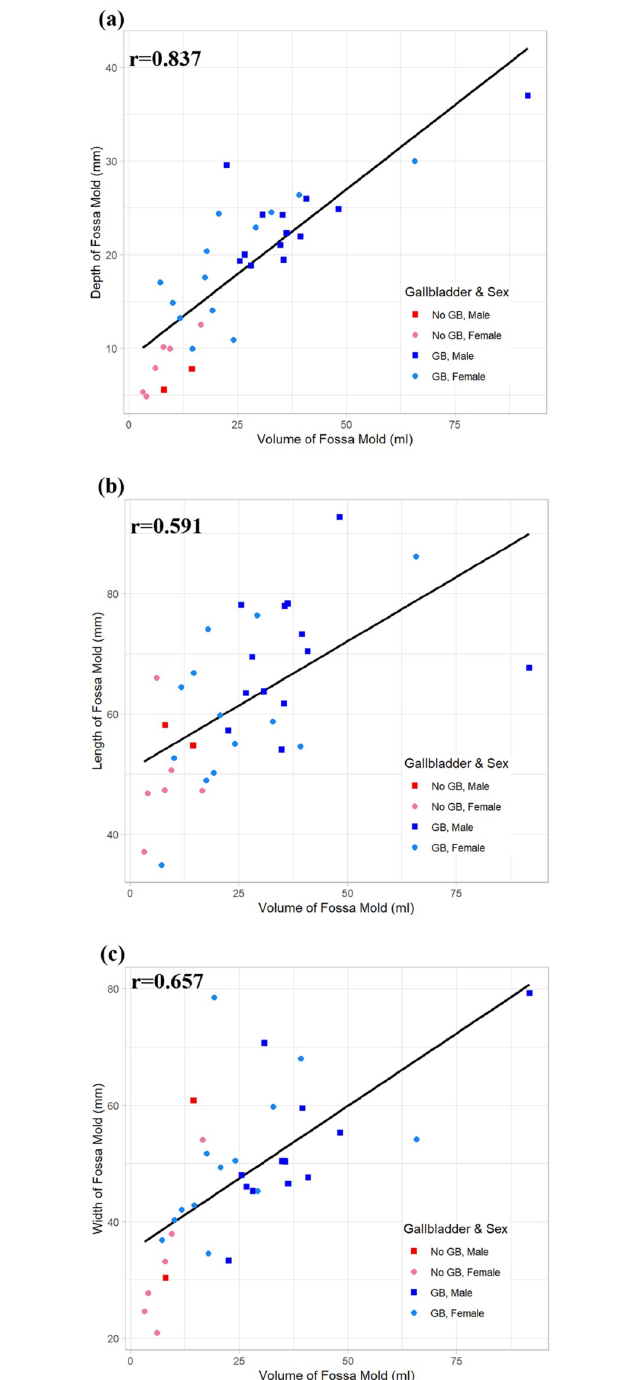
Fig 2. Plots gallbladder fossae volumes versus different dimensions of the fossa mold for livers with (blue) and without (red) gallbladders (males (squares), females (circles)), showing Pearson’s correlation coefficient (r) for each comparison. (a) Fossa volume versus fossa depth. (b) Fossa volume versus fossa length. (c) Fossa volume versus fossa width.